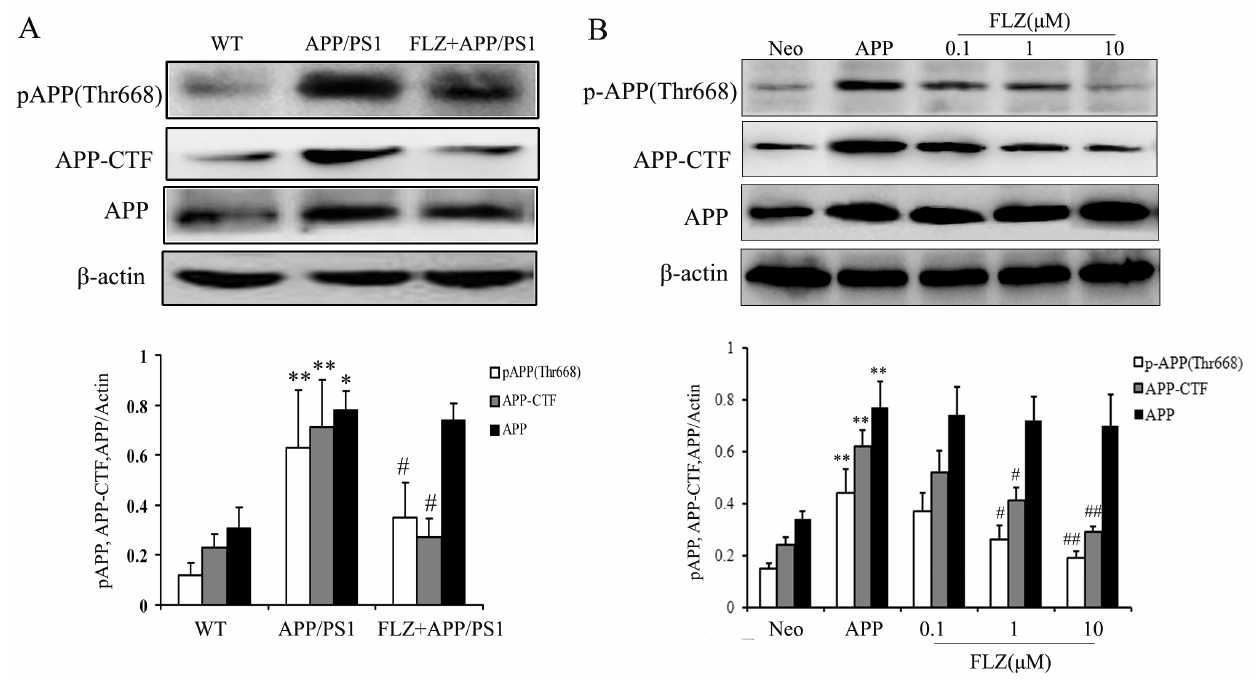
Figure 5. FLZ decreased the expression of phospho-APP and APP-CTF. APP/PS1 double transgenic mice were orally treated with FLZ 150 mg/kg for 20 weeks. SH-SY5Y (APPwt/swe) cells were grown in ‘‘stimulating medium’’ containing 50% DMEM, 50% Opti-MEM, 0.5% FBS, 200 m g/ ml G418 and 10 mM butyric acid sodium salt for 12 h to induce the transgene expression. FLZ (0.1, 1 and 10 m M) were incubated with cells for 24 h. Antibodies against p-APP, APP-CTF and APP were subjected to Western blot assay. A representative immunoblot from 4 mice was shown. Results were expressed as mean 6 SD. (A) Western blot assay of APP, phospho-APP and APP-CTF in hippocampus of APP/PS1 mice. * P , 0.05,** P , 0.01 vs . WT mice; # P , 0.05 vs . APP/PS1 mice. (B) Western blot assay of APP, phospho-APP and APP-CTF in SH-SY5Y (APPwt/swe) cells. ** P , 0.01 vs . Neo SH-SY5Y cells, # P , 0.05, ## P , 0.01 vs . solvent-treated SH-SY5Y (APPwt/swe) cells.